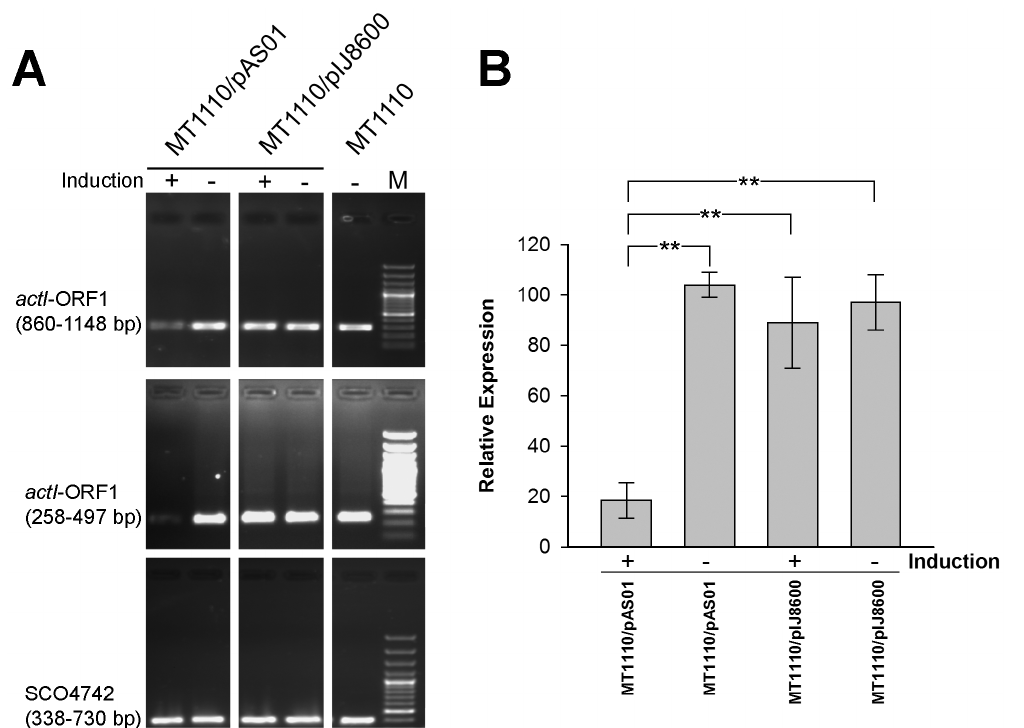
Figure 5. Effect of expressed antisense RNA on act I-ORF1 mRNA levels. RT-PCR of act I-ORF1 from RNA extracted from MT1110 strains grown for 3 days in R5 liquid medium that contained thiostrepton ( + ) or DMSO (-) as a control. Two primers sets (top and middle panel) designed to amplify different regions of the actI -ORF1 mRNA were used, with SCO4742 (bottom panel) serving as an internal control. M=100 bp DNA ladder. (B) qRT-PCR of act I-ORF1; SCO4742 served as the internal reference and expression was calculated relative to uninduced MT1110. Error bars represent standard error for biological replicates ( n =3 ** highly significant difference, one way ANOVA, F =11.96, p= , 0.01).